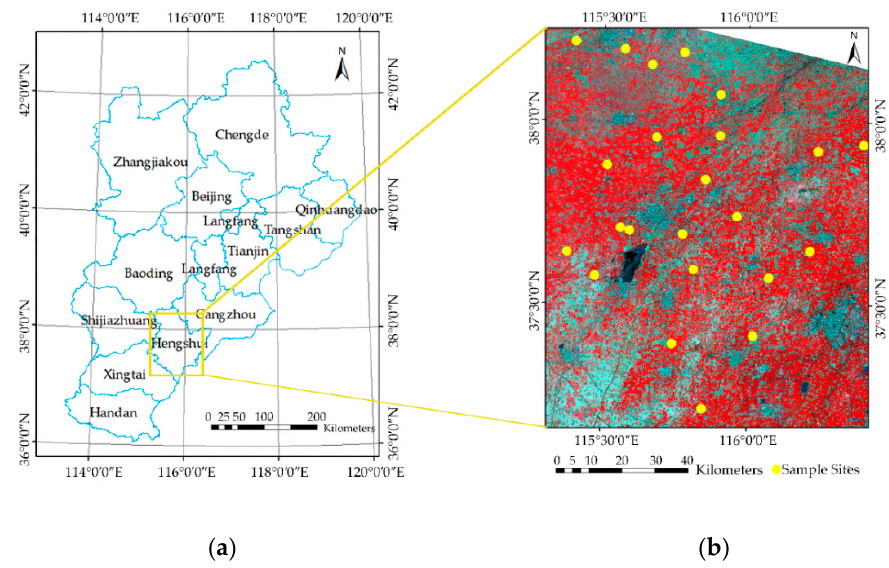
Figure 1. The geographic location of the whole study area is represented by the yellow rectangle in the left figure ( a ). The distribution of the sample sites is shown by the yellow points on the standard false color composited GaoFen-1 Wide Field View (GF-1 WFV) data ( b ).